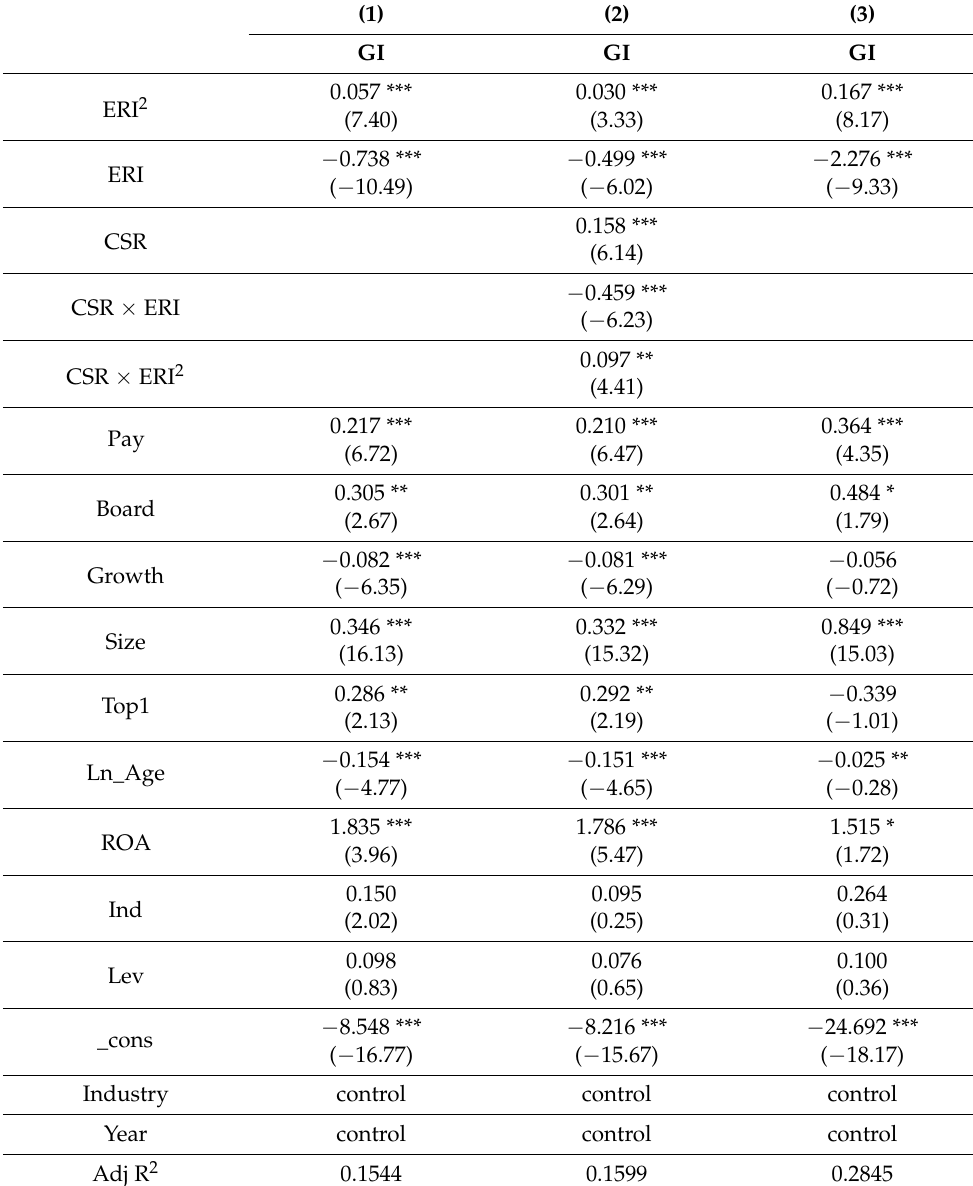
Table 6. Results of the robustness